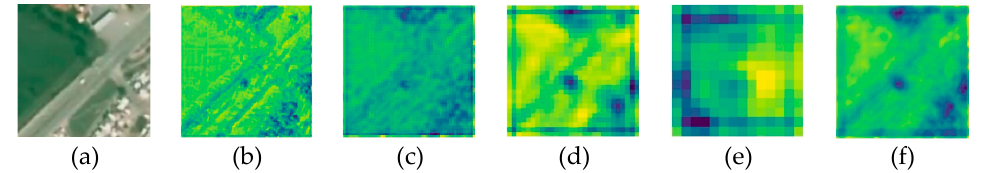
Figure 3. Feature visualization of various layers from the VGG-19 Networks. ( a ) Input image. ( b ) Conv2-3 layer features. ( c ) Conv3-4 layer features. ( d ) Conv4-4 layer features. ( e ) Conv5-4 layer features. ( f ) fused image features.